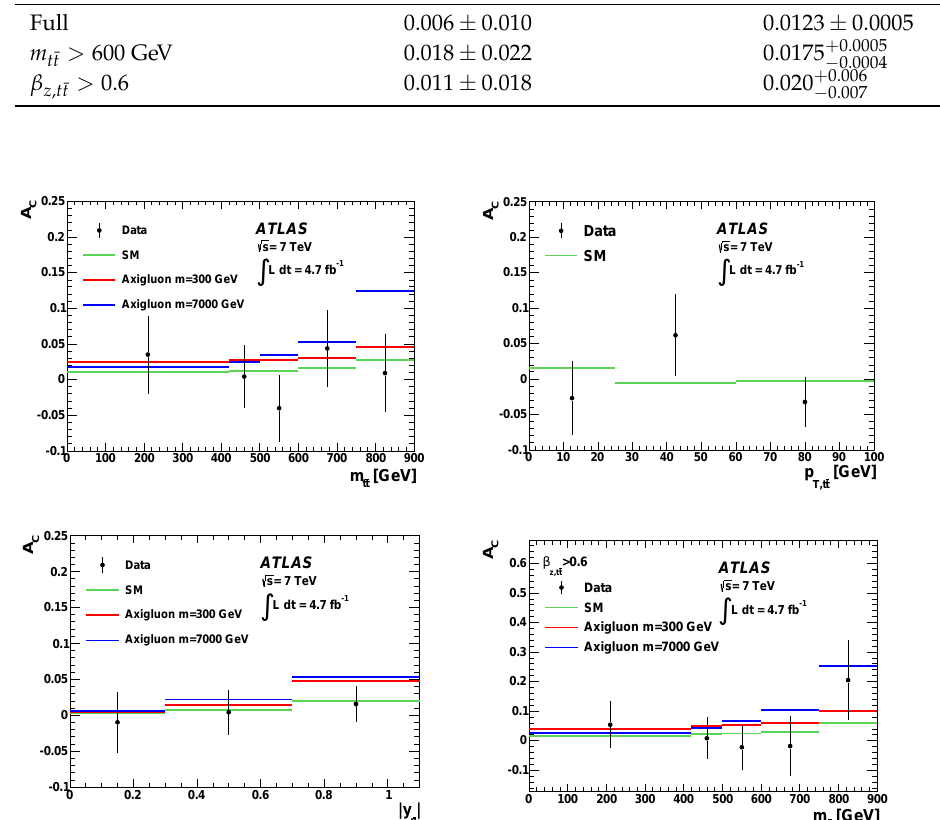
| ( bottom left ) after Figure 6. Distributions of A t ¯ t as a function of m t ¯ t ( top left ), p t ¯ t ( top right ), and | y t ¯ t C T unfolding, for the electron and muon channels combined. The A t ¯ t distribution as a function of m t ¯ t for C β z , t ¯ t > 0.6, is also shown ( bottom right ). The A t ¯ t values after the unfolding (points) are compared C with the SM predictions (green lines) and the predictions for a colour–octet axigluon with a mass of 300 GeV (red lines) and 7000 GeV (blue lines), respectively. The thickness of the lines represents the factorization and renormalization scale uncertainties in the corresponding theoretical predictions. The values plotted are the average A t ¯ t in each bin. The error bars include both the statistical and the C systematic uncertainties